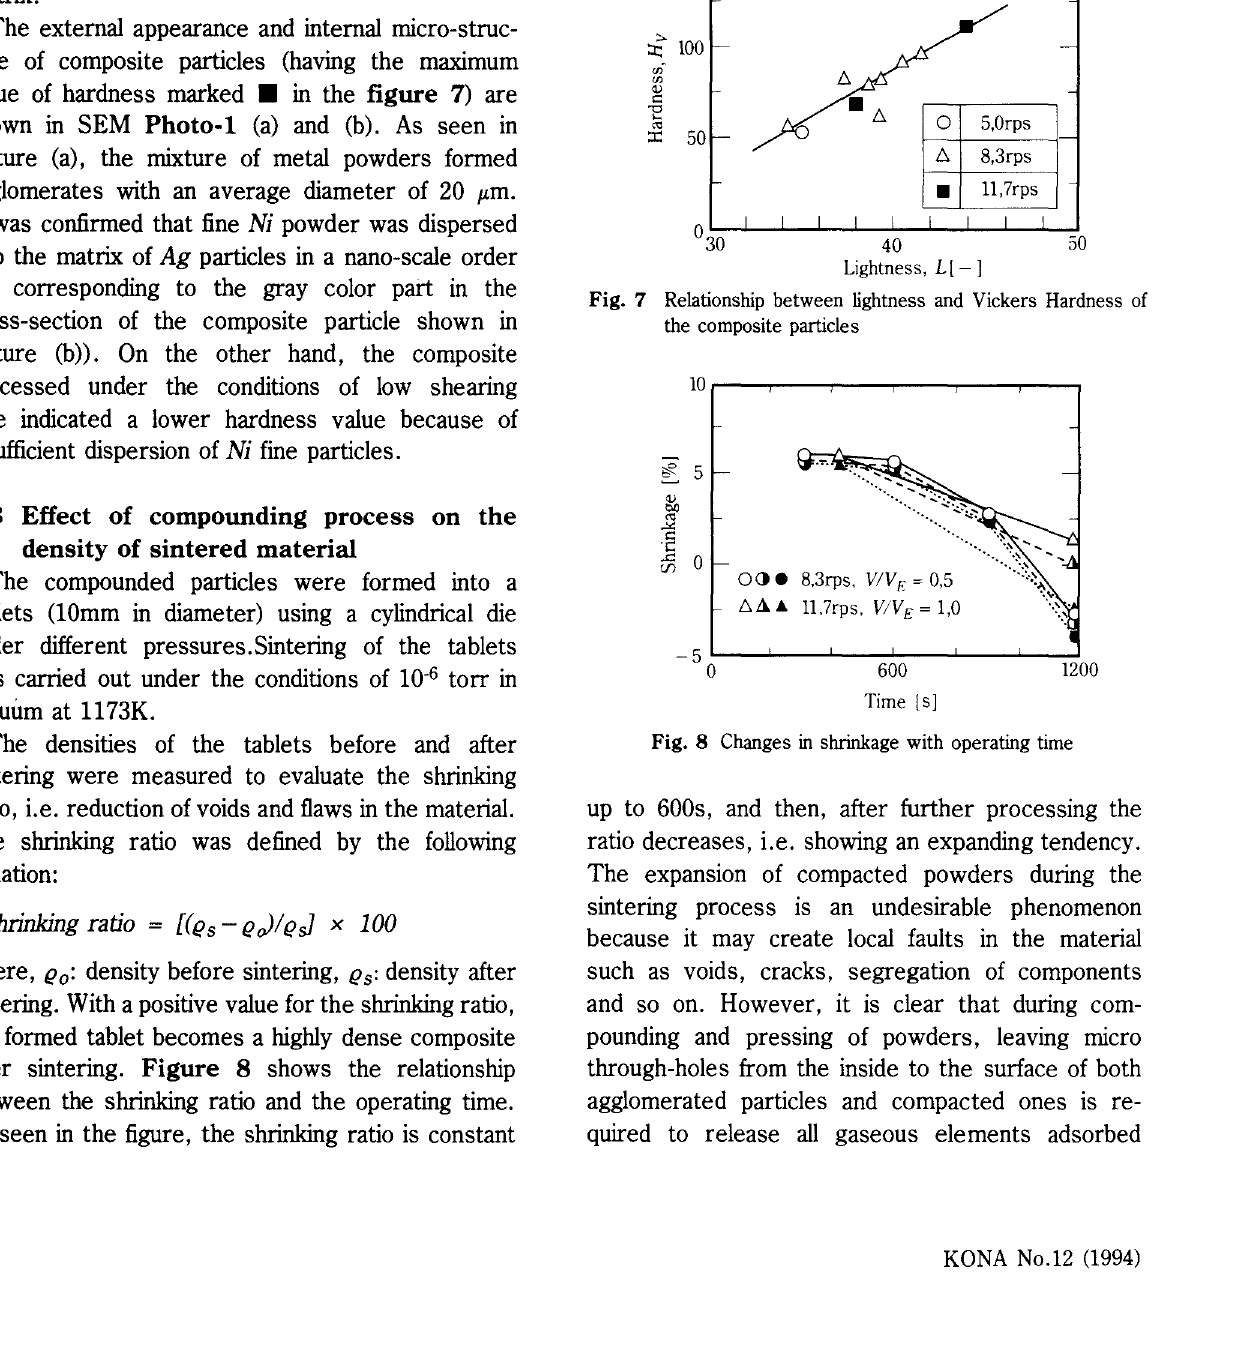
Fig. 7 Relationship between lightness and Vickers Hardness of the composite particles 10.--~-~--,----,-~---.,